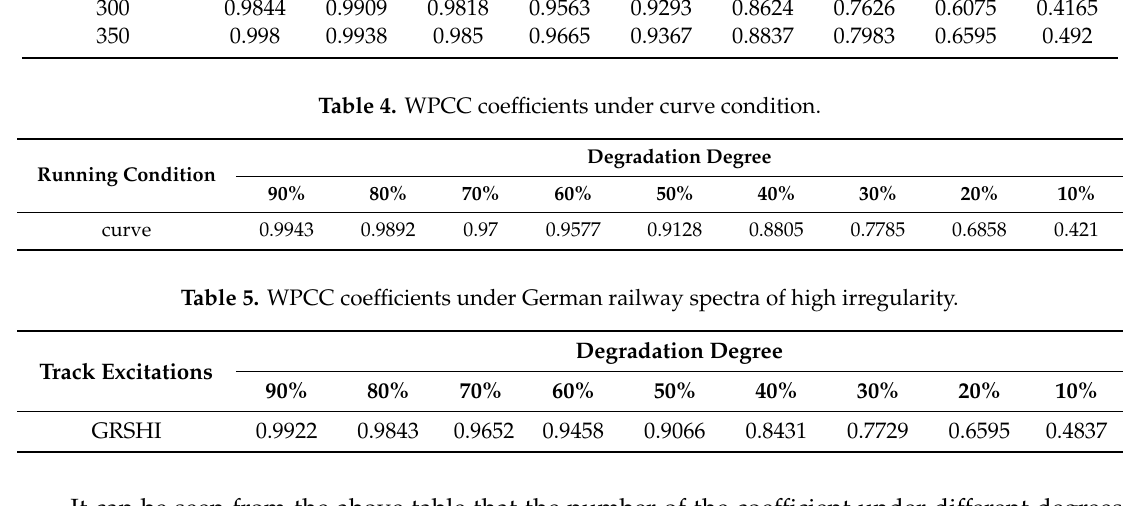
Table 5. WPCC coefficients under German railway spectra of high irregularity.